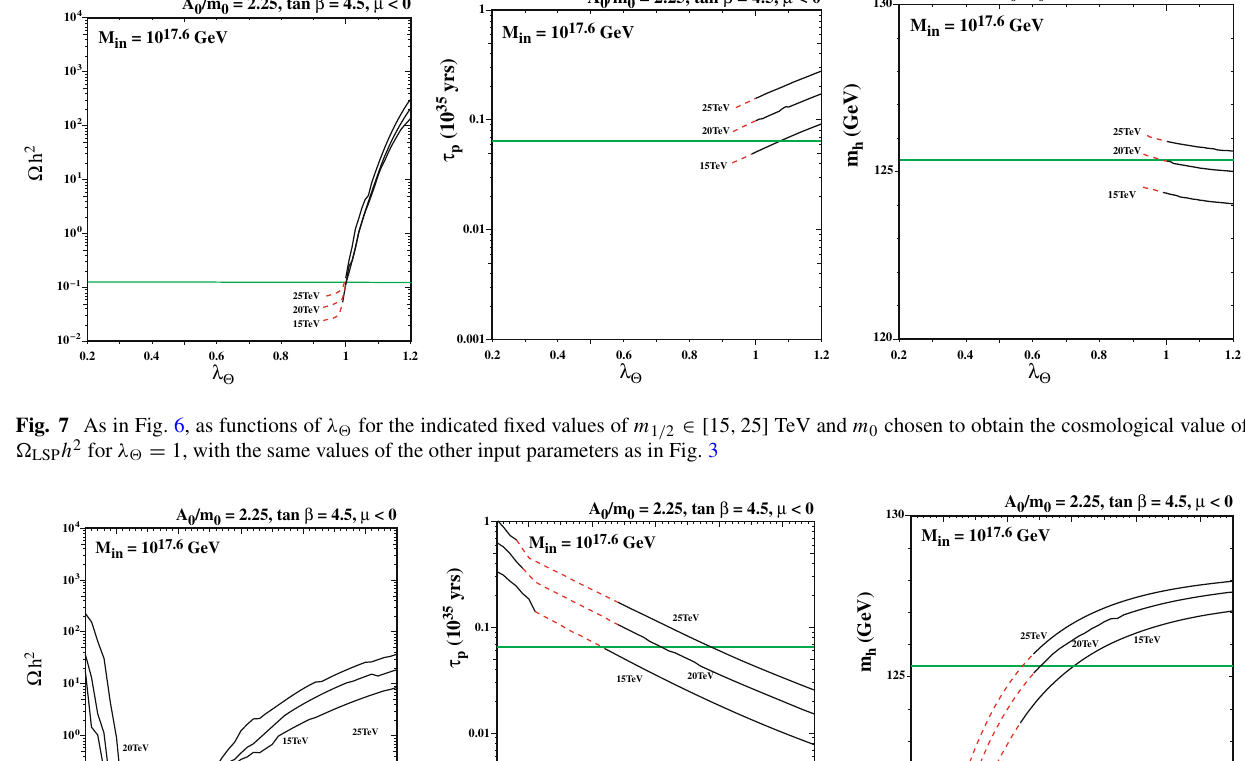
Fig. 6 Values of (cid:21) LSP h 2 (left panel), τ( p → K + ν) (center panel) and m h (right panel) as functions of m 0 for the indicated fixed values of m 1 / 2 ∈ [ 15 , 25 ] TeV and for the same input parameters as in the upper left panel of Fig. 3. Values calculated when the LSP is a bino are shown as solid black lines, becoming dashed red lines when the LSP